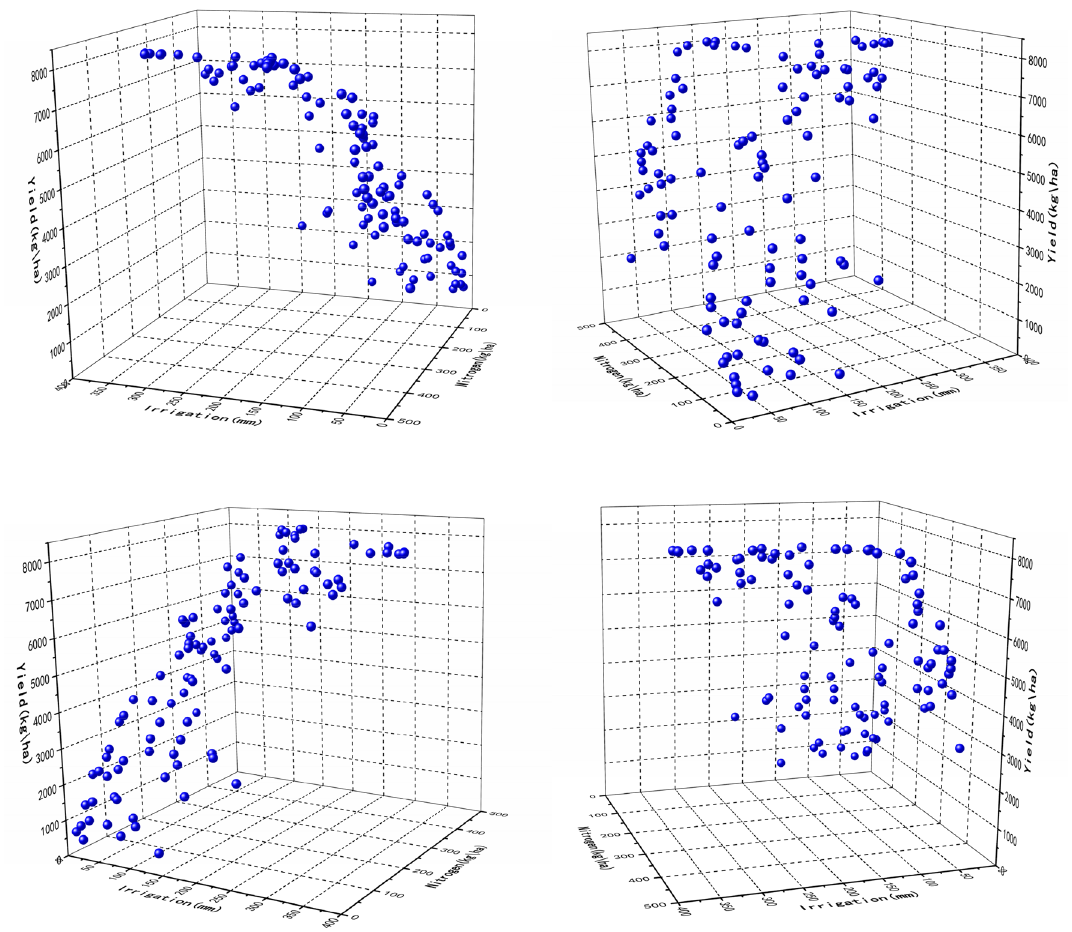
Figure 7. Optimization of yield, irrigation, and nitrogen application by traversing fertilizer application